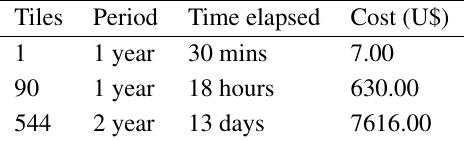
Figure 3. Data volume (TB) of surface reflectance images for Brazil